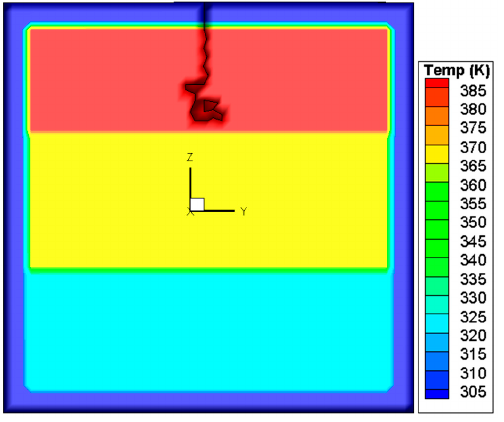
Figure 20. Crack path predicted by the CTOA-based crack growth criterion.